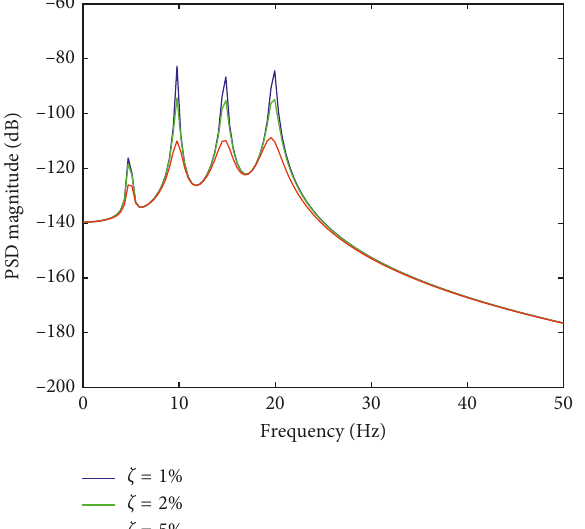
Figure 6: Analytic PSD function damping ratio comparison.